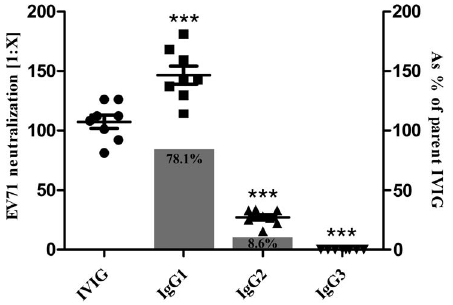
Figure 2. The contribution of each human IgG subclass to EV71 neutralization. Neutralization tests of IgG subclasses were performed using in RD cells for at least 3 times. Error bars represent standard deviation (SD), and statistical analysis was performed by using GraphPad Prism v5.0 software by Student’s t test (unpaired, two-tailed). ***, p , 0.005 versus parent IVIG